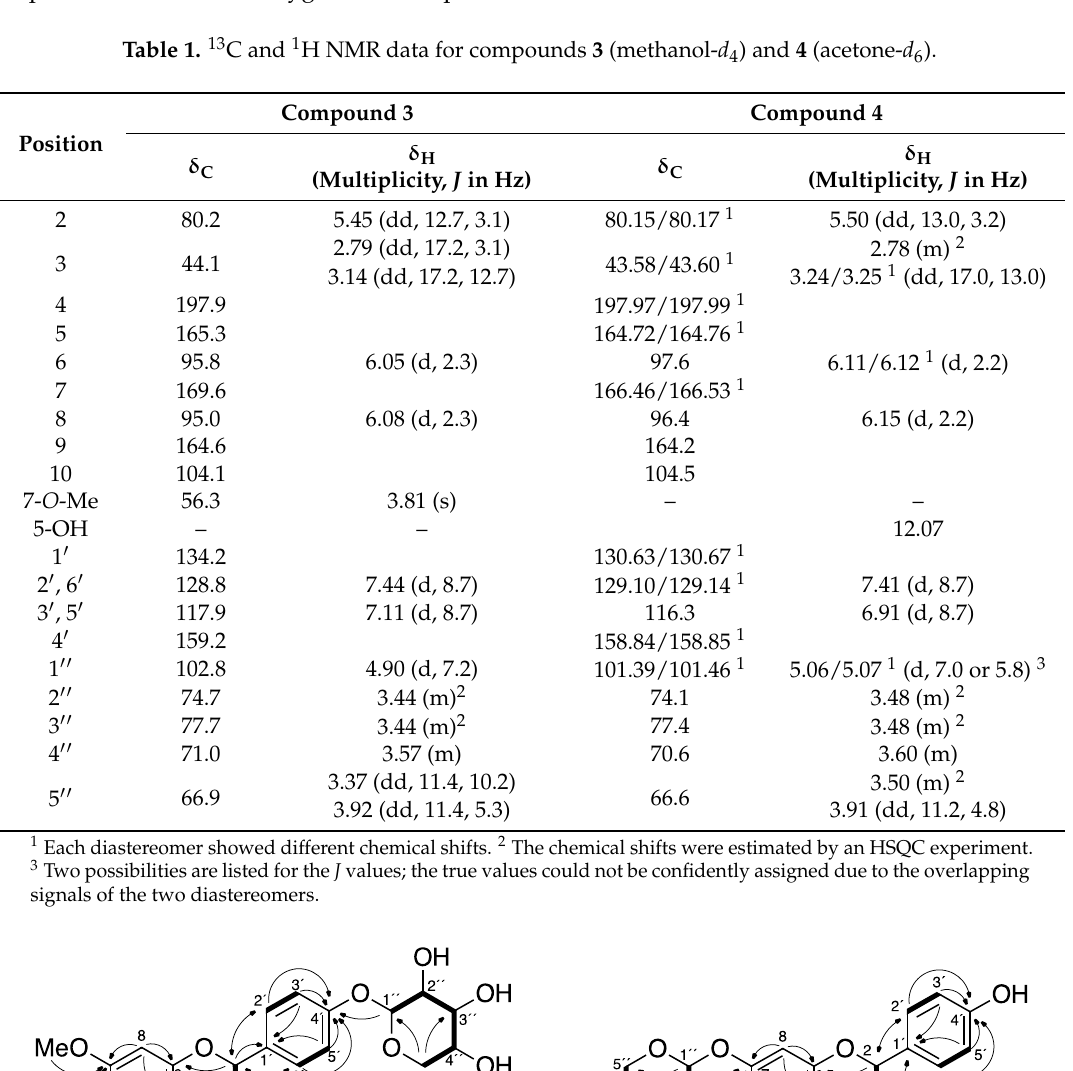
Table 1. 13 C and 1 H NMR data for compounds 3 (methanol- d 4 ) and 4 (acetone- d 6 ).